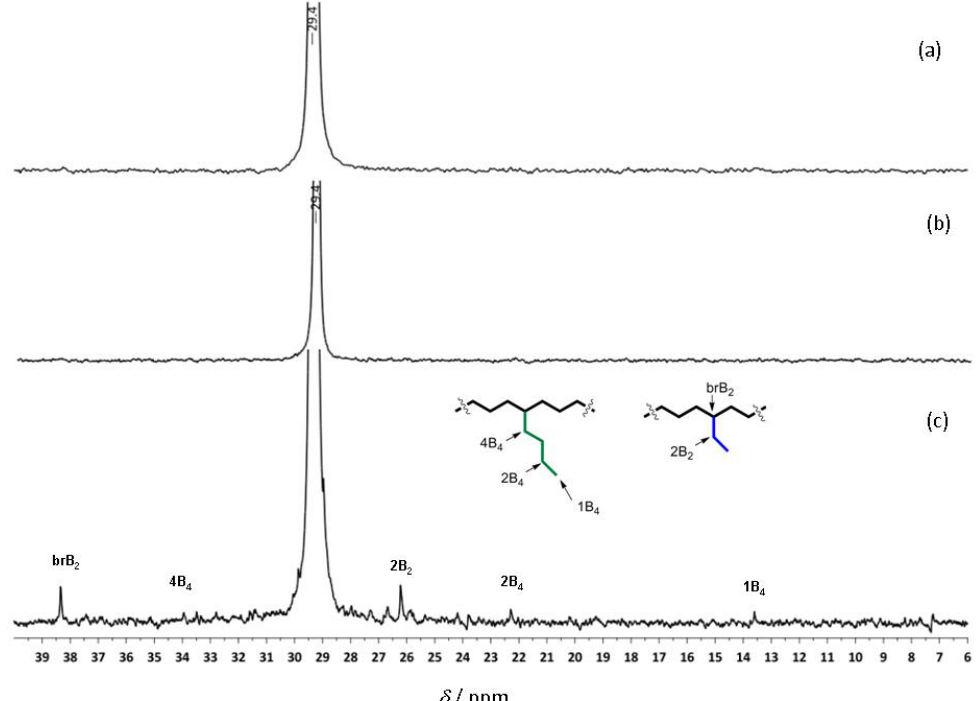
Figure 3. 13 C-NMR spectra of PE obtained by the action of (a) Ti-3 at 50 °C, (b) Ti-8 at 50 °C, (c) Ti-8 at 75 °C (all activated by